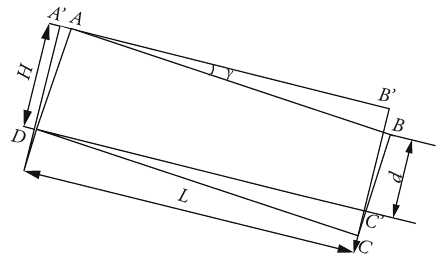
Figure 12: Geometric relations when rock